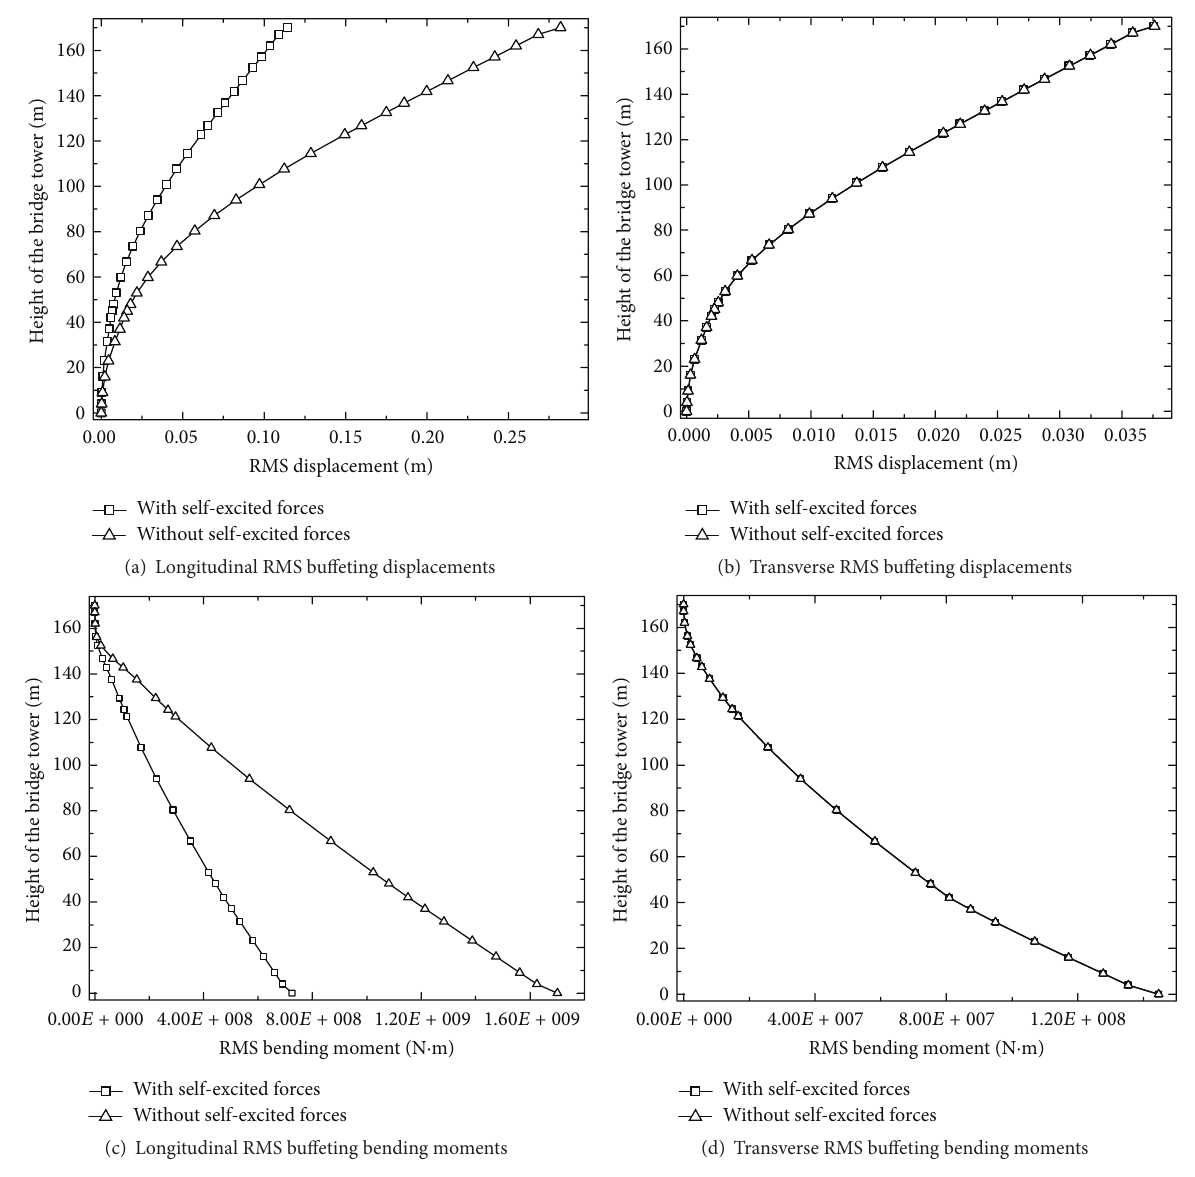
Figure 16: Comparisons of RMS buffeting responses of bridge tower number